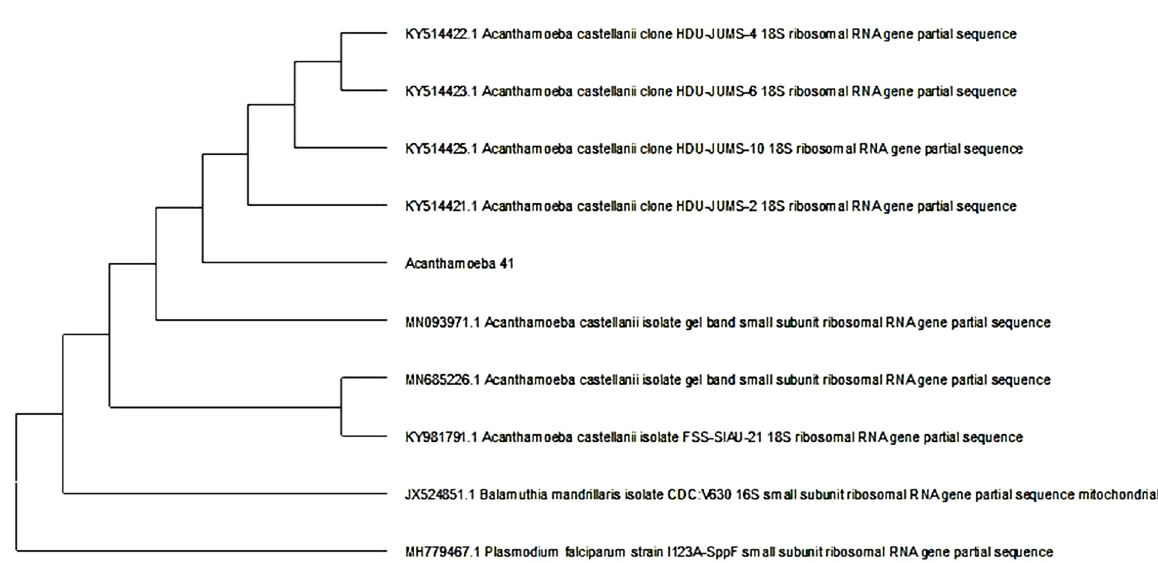
Fig 5. Phylogenetic tree derived by aligning the 18s rDNA sequence of the strain isolate (41). The results obtained showed that its 18s rDNA sequence shared considerable homology with A . castellanii .